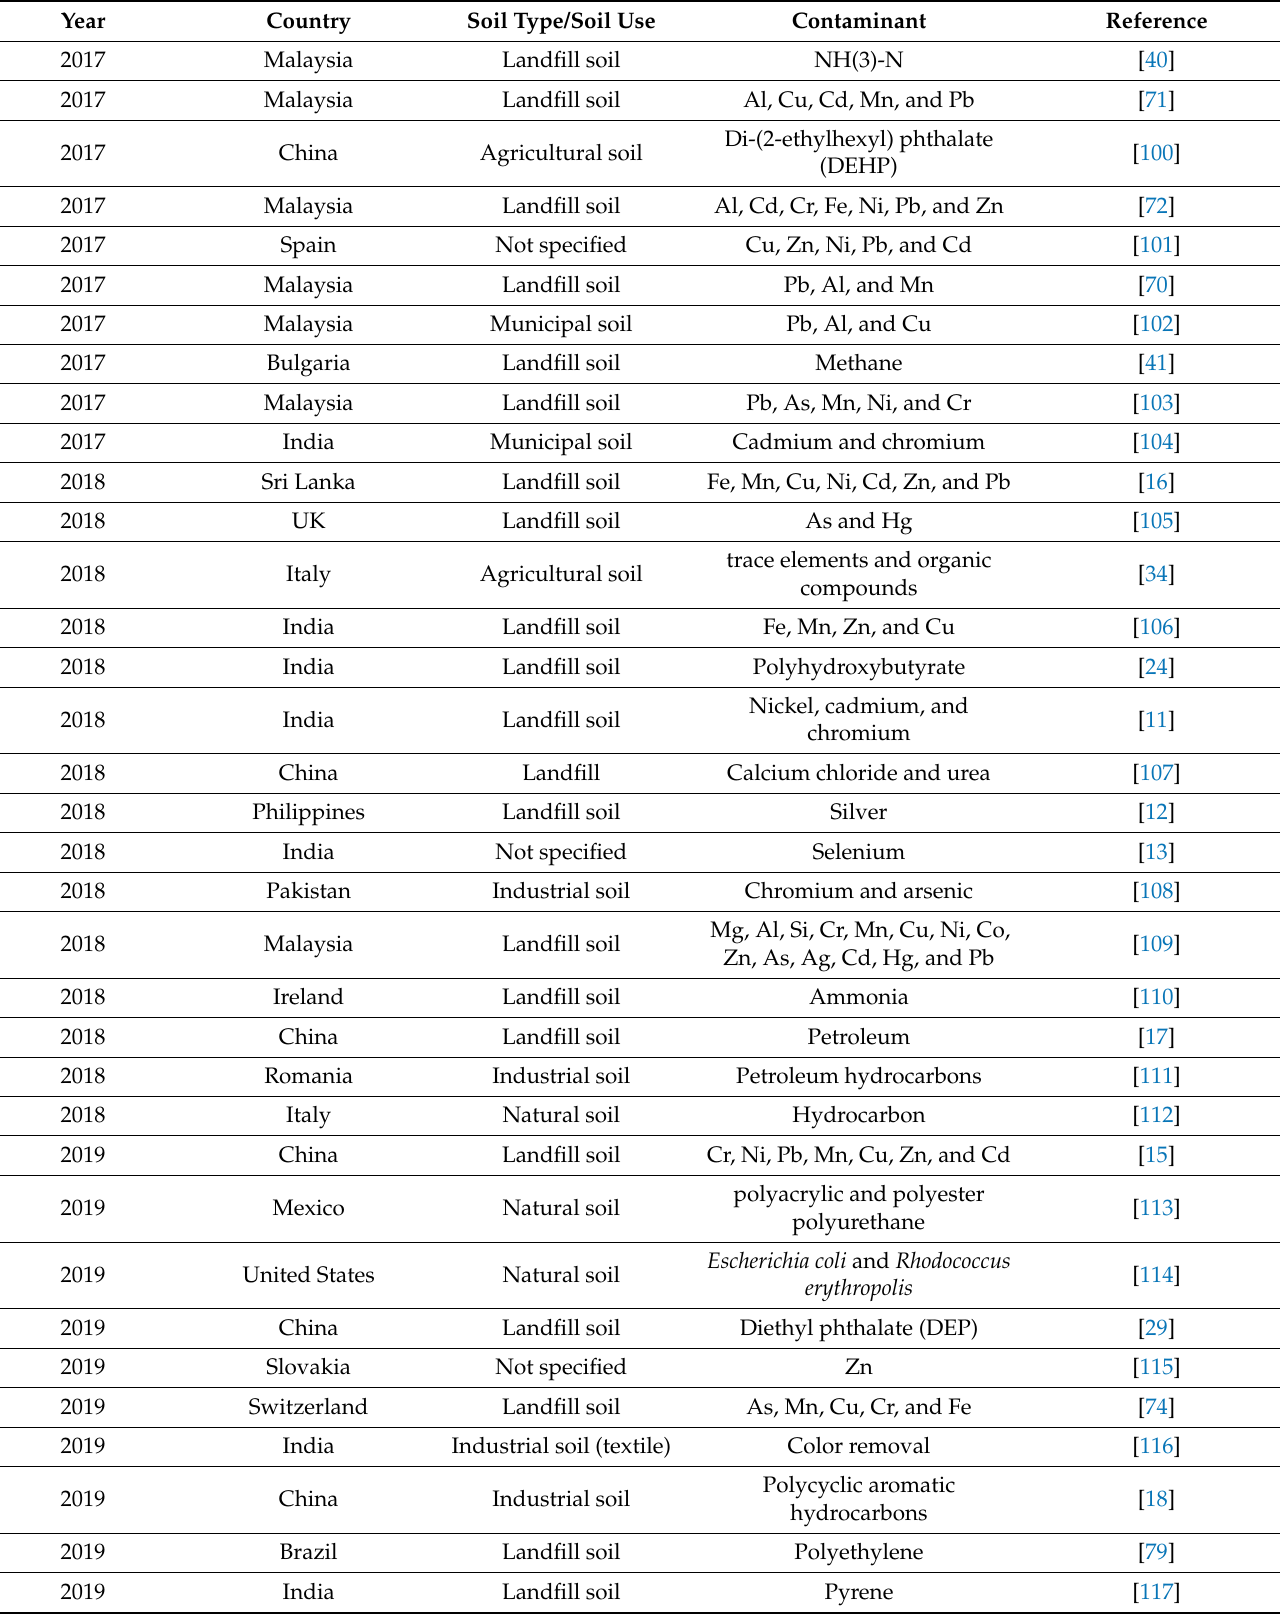
Table 6. Different pollutants studied in different countries with different soil types around the